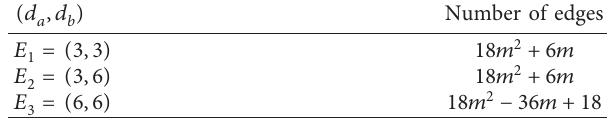
Table 2: Edge partition of TP